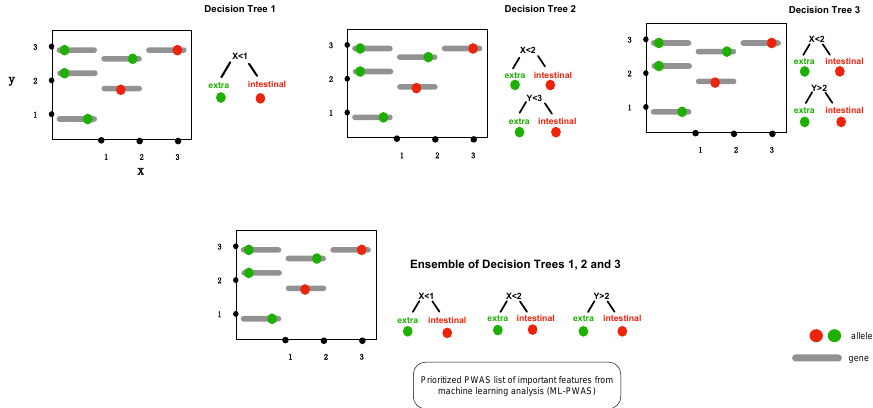
Figure 2. The conceptual framework diagram depicting machine learning in bacterial genome-wide association using extreme gradient boosting (XGBoost). Boosting is a technique of combining a set of weak classifiers or decision trees to increase prediction accuracy. Red dots represent an allelic variant, each grey bar represents a unique allele. Individual decision trees (1, 2, 3) fail to fully capture the allelic variants associated with the phenotype (e.g., extraintestinal abortion), but combining the trees together results in a process called boosting as it increases the discriminative power.